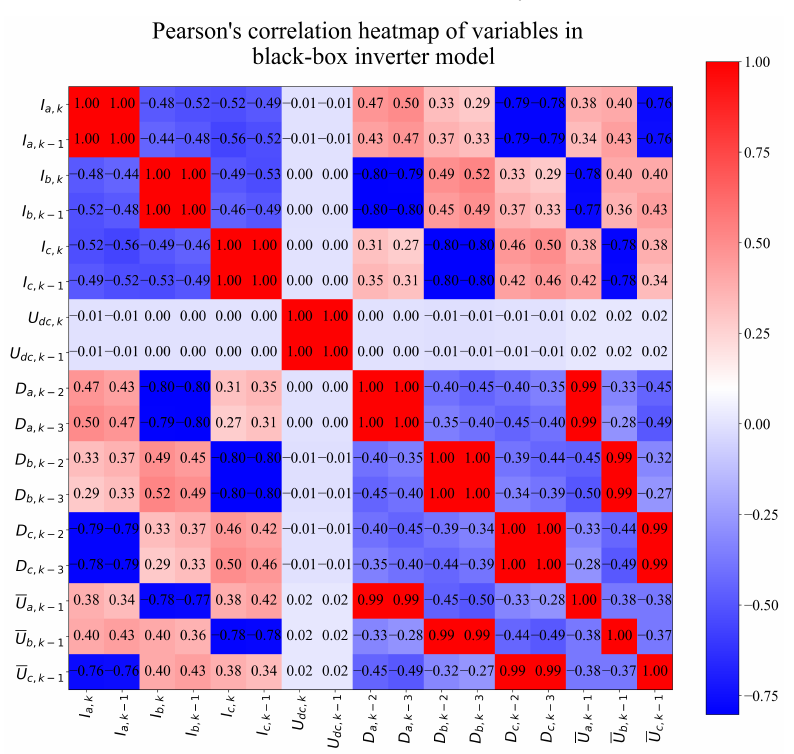
Figure A2. The Pearson’s correlation heatmap for variables in black-box inverter